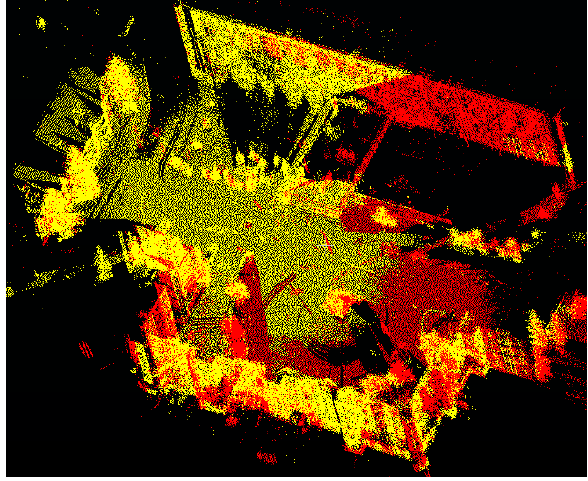
Figure 8. The two point clouds of Yamnuska hall after